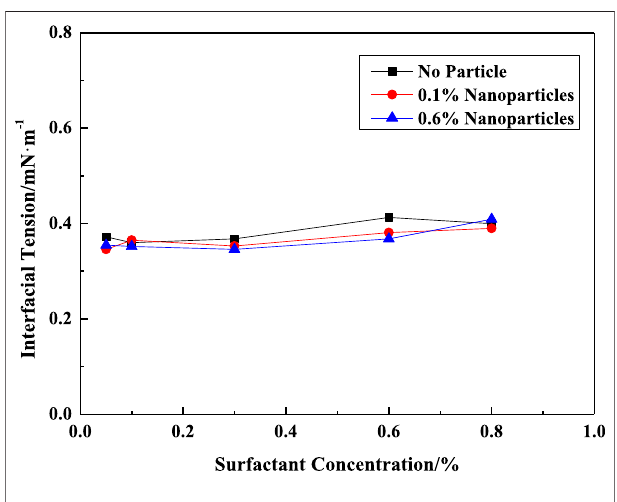
FIGURE 13 | IFT between the VES solution and Zhuangxi crude oil. (A) ( w (LBA + SDS) (cid:2) 0.8%, LBA:SDS (cid:2) 3:1, T (cid:2) 50 ° C, w (NaCl) (cid:2) 4%, K (cid:2) 500mD). (B) ( w (LBA+SDS) (cid:2) 0.8%,LBA:SDS (cid:2) 3:1,T (cid:2) 50 ° C, w (NaCl) (cid:2) 4%, K (cid:2) 1500mD). (C) ( w (SiO 2 ) (cid:2) 0.8%, w (LBA + SDS) (cid:2) 0.8%, LBA:SDS (cid:2)